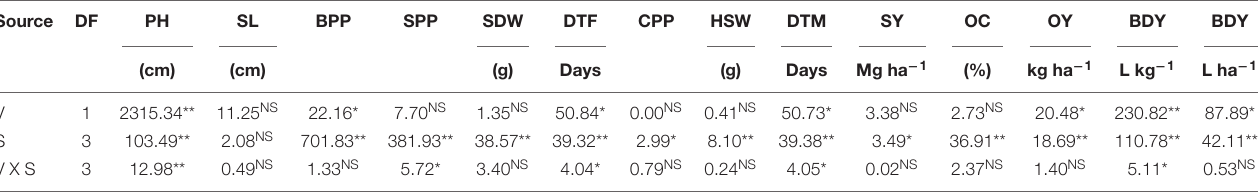
TABLE 3 | ANOVA sources, F -values, and levels of statistical significance in plant morphology and biomass yield. Source